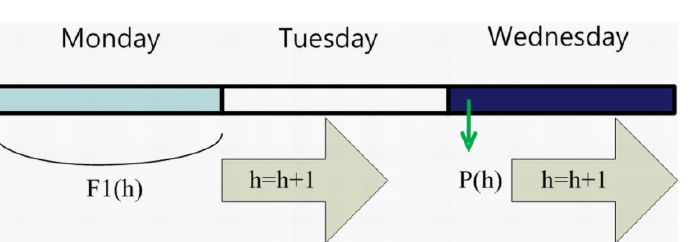
Figure 4. Moving data window (F1(h)) corresponding to forecasted P(h).